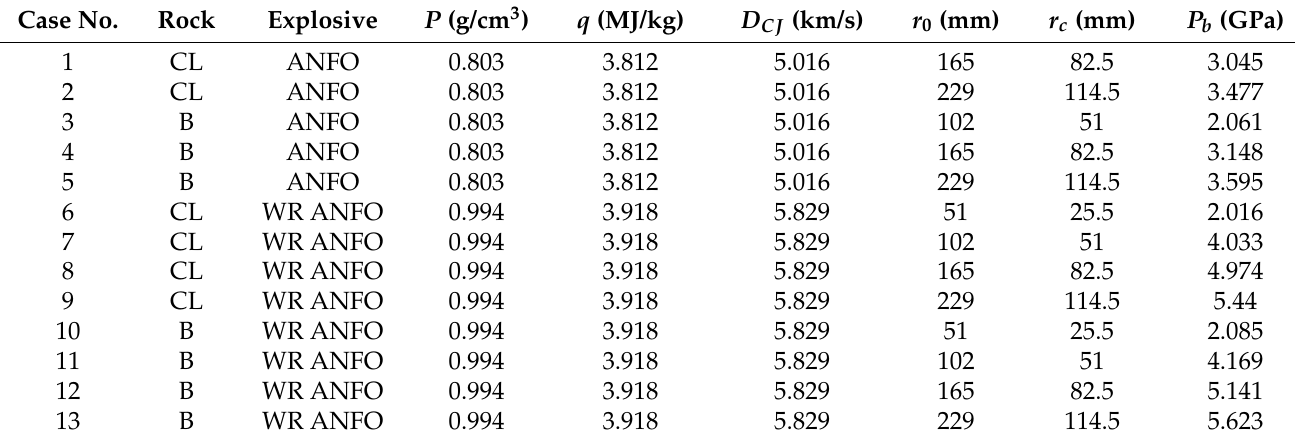
Table 5. The characteristics of the rocks, explosives, and blast holes in the 13 studied samples.